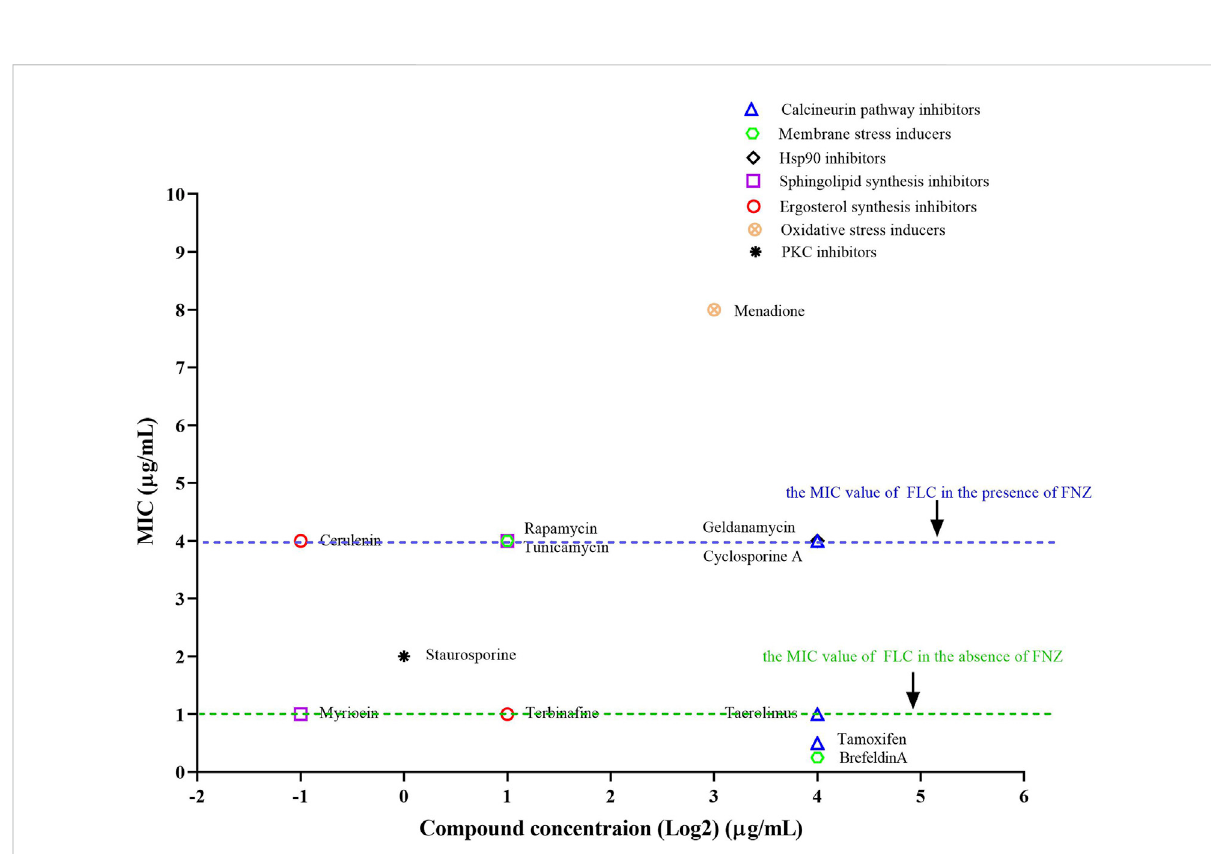
The synergistic antifungal activity of FLC and some compounds. Dose-matrix titration assays showed that some compounds (concentration range from 0.25 to 16 μ g/ml) enhanced the antifungal activity of FLC in the presence of FNZ (10 μ g/ml) (The MIC values of FLC reduced from 4 to 1 μ g/ml or